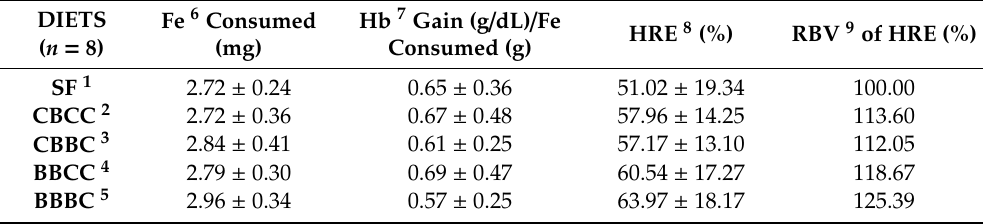
Table 7. Iron consumed, hemoglobin gain / iron consumed, hemoglobin regeneration e ffi ciency (HRE), and relative bioavailability value (RBV of